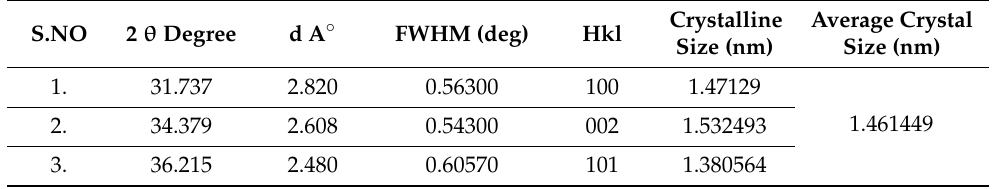
Figure 2. XRD analyses of zinc oxide nanoparticles (ZNP) with indexed crystalline peaks. Table 1. Crystalline size and hkl value of observed crystalline peaks.